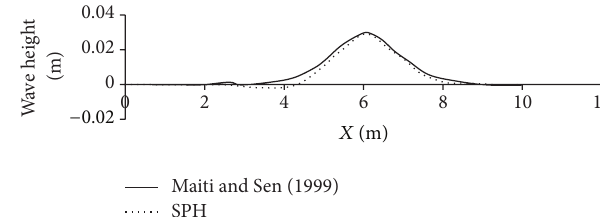
Figure 2: Computational domain.